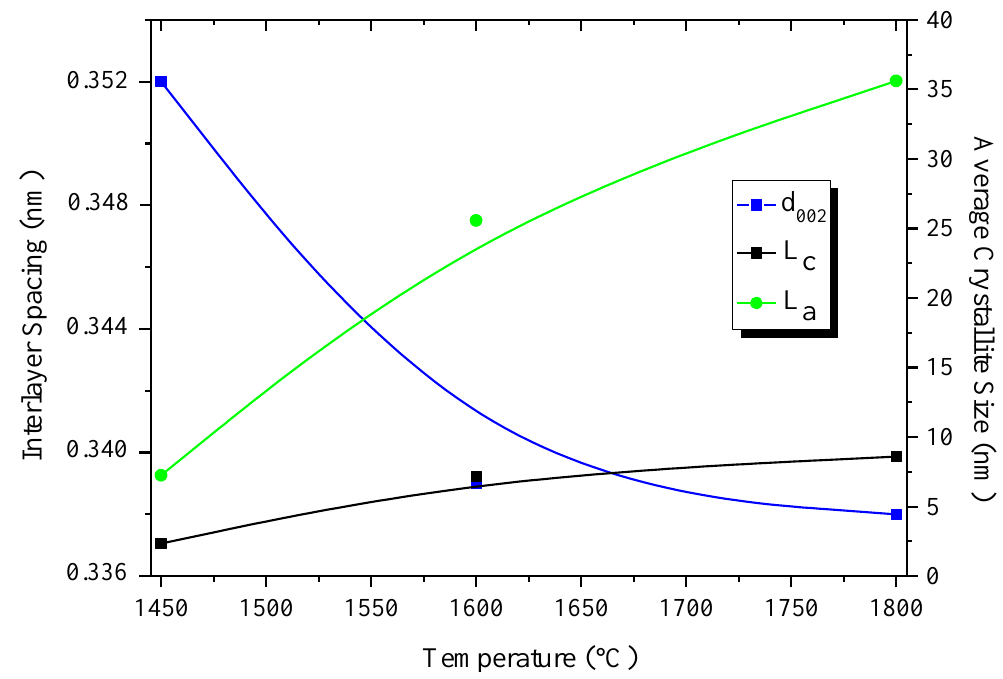
Figure 6. Evolution of the average crystallite sizes and interlayer spacing vs. annealing